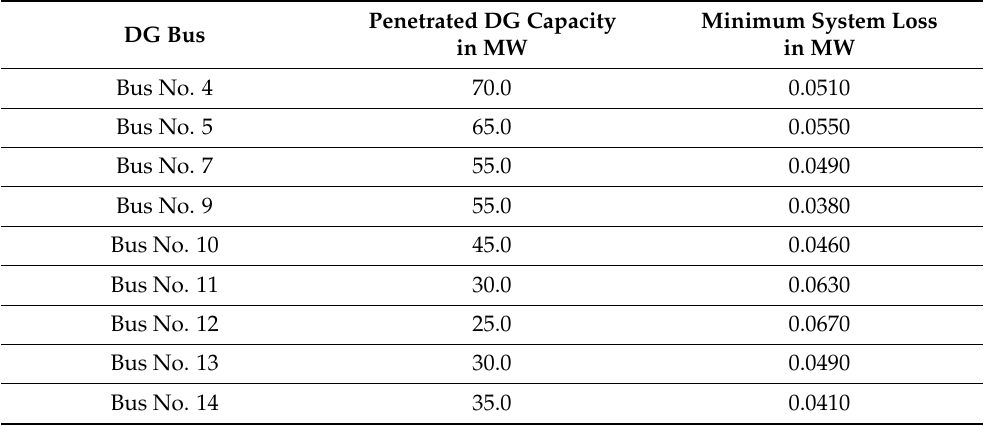
Table 7. The load buses with appropriate DG capacity for minimum power loss at each load bus for the 14-bus system of IEEE.